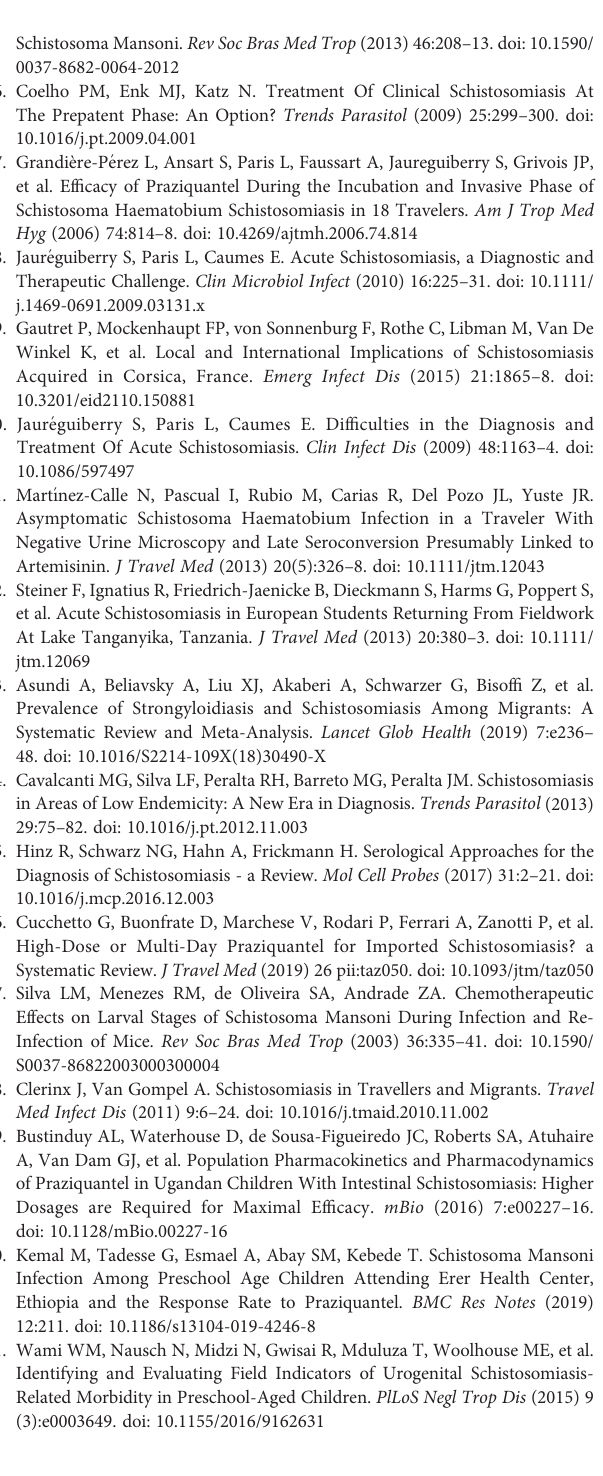
Supplementary Figure 1 | Schematic representation of Schistosoma DNA, IgG and urinary antigen detection pre and post-treatment response during short and long-term follow up. Fecal samples from children treated with three sequential doses of PZQ (day 0, 30 and 45) were tested byreal-time PCR (A) . Serum (B) and urine (C) samples were analyzed by ELISA-IgG anti-SMMA and POC-CCA, respectively. Ct, Cycle Threshold (real-time PCR); Ct < 38, Reactive; Ct >38, Not Reactive; A.U., Arbitrary Units; ELISA IgG, Positive ≥ 1 AU. Negative < 1 AU;